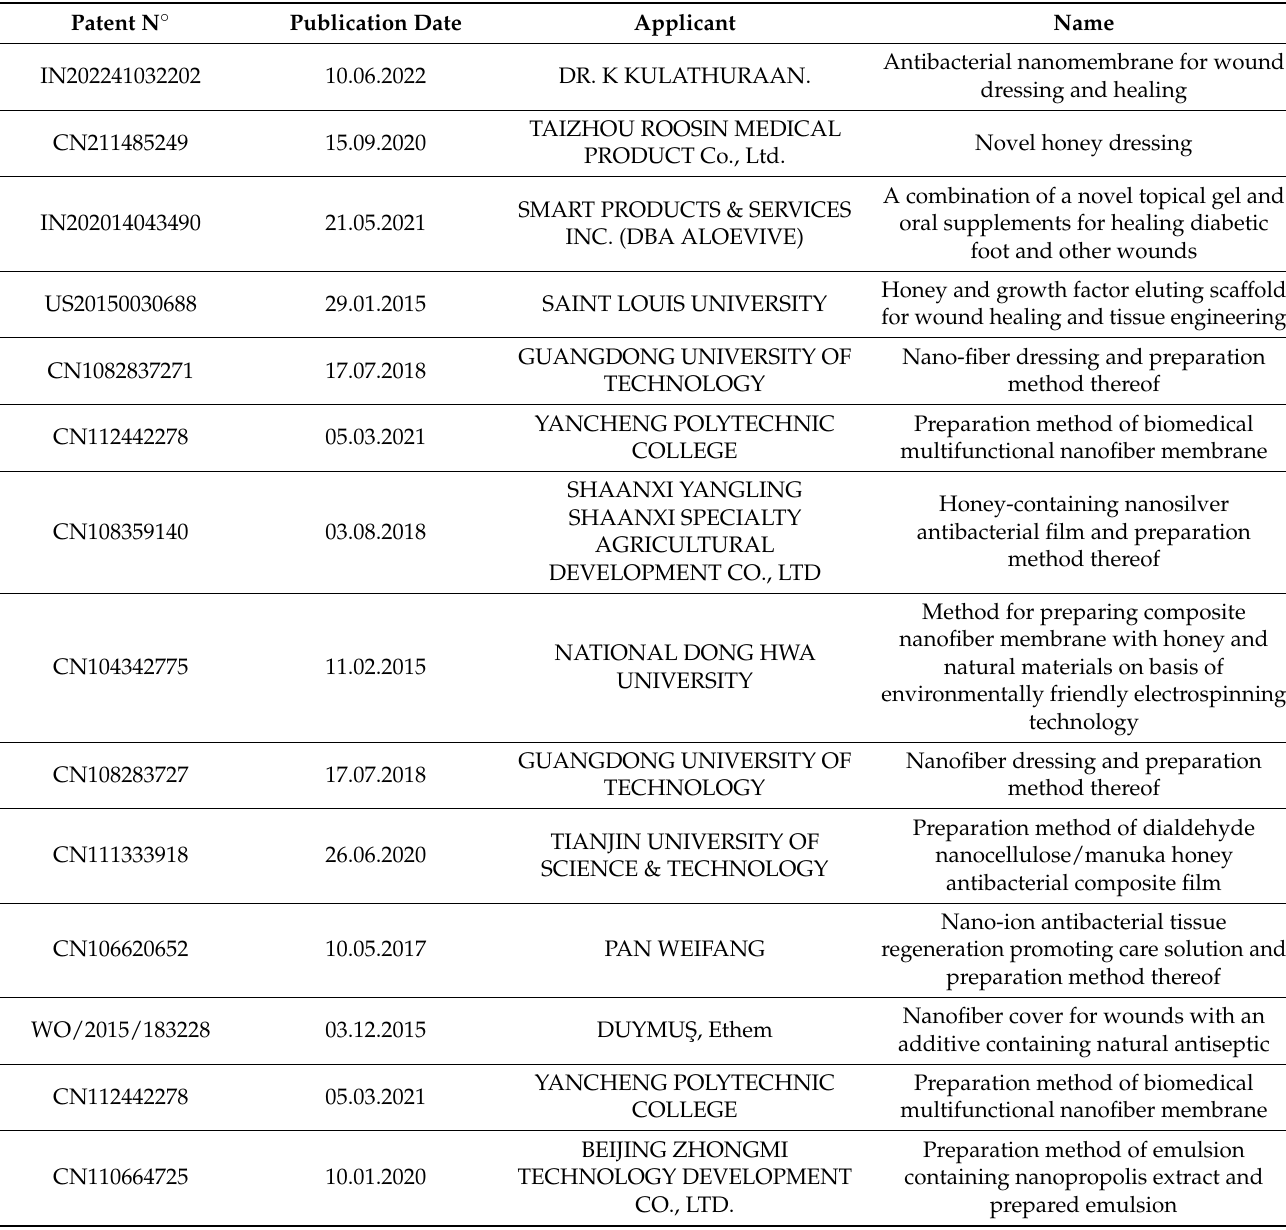
Table 3. Patents, publication date, applicant and description of bionanomaterial based on honey or